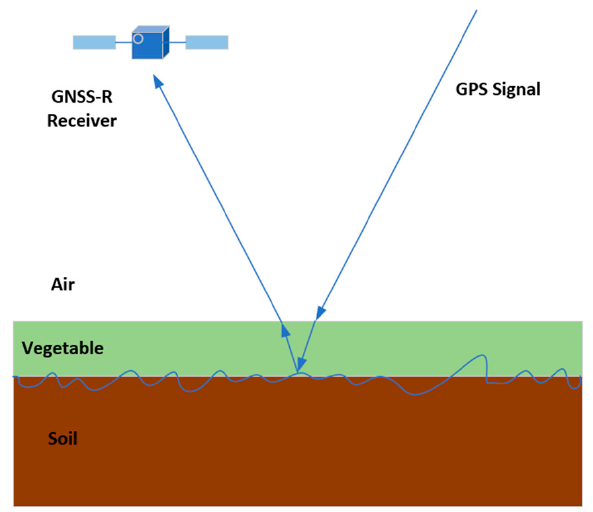
Figure 6. Schematic diagram of a three-layer model of air, vegetation and soil. Carno-Luengo et al. [164] conducted the first GNSS-R experiment on a global scale, performed on-board the SMAP (Soil Moisture Active–Passive) satellite, to study soil mois- ture and biomass retrieval. The scattered GPS L2 signal was received by the SMAP’s dual-polarization (Horizontal and Vertical) radar receiver. By setting the optimum coherent integration time of 5 ms, the DDM data were obtained through signal processing. The SNR, the Polarimetric Ratio (PR), and the width of the waveforms’ trailing and leading edges were used to analyze the Earth’s topography and Above-Ground Biomass